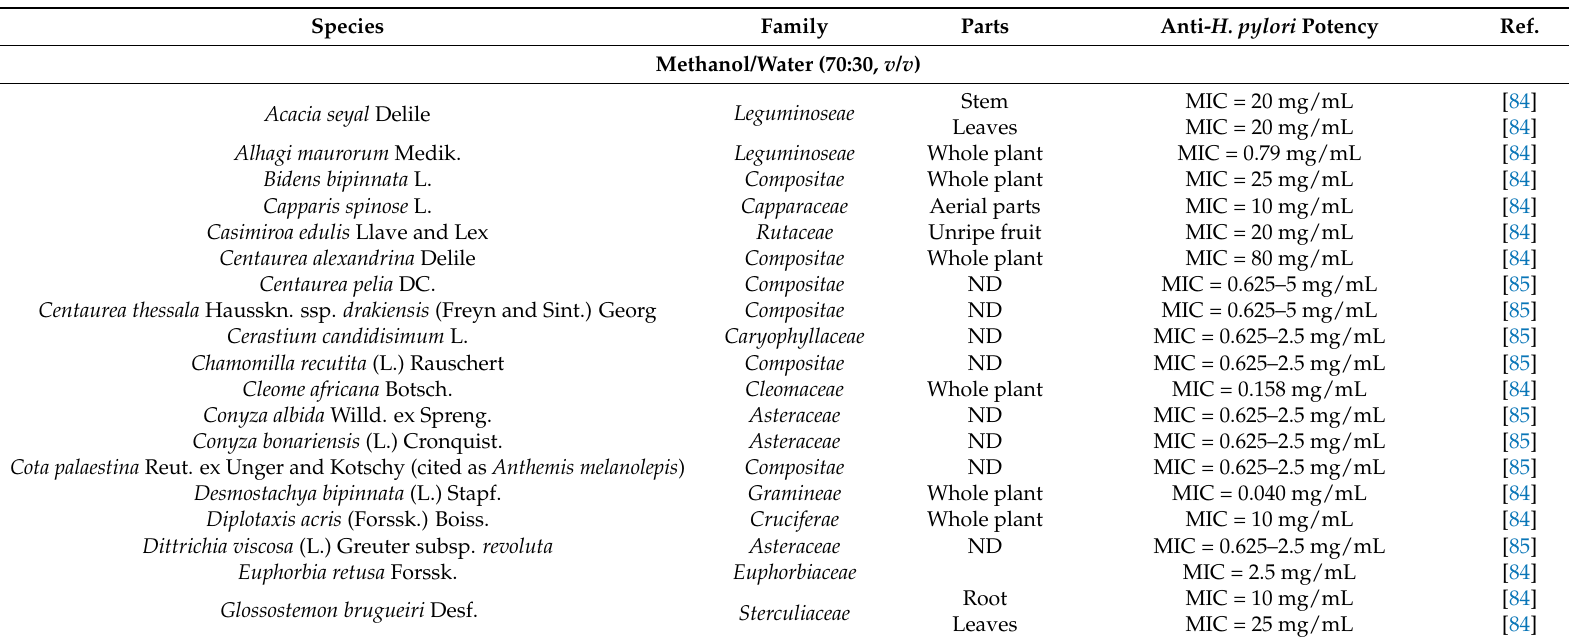
Table 8. Plant methanol/water, ethanol/water, methanol/petroleum, and methanol/dichloromethane extracts with anti- H. pylori